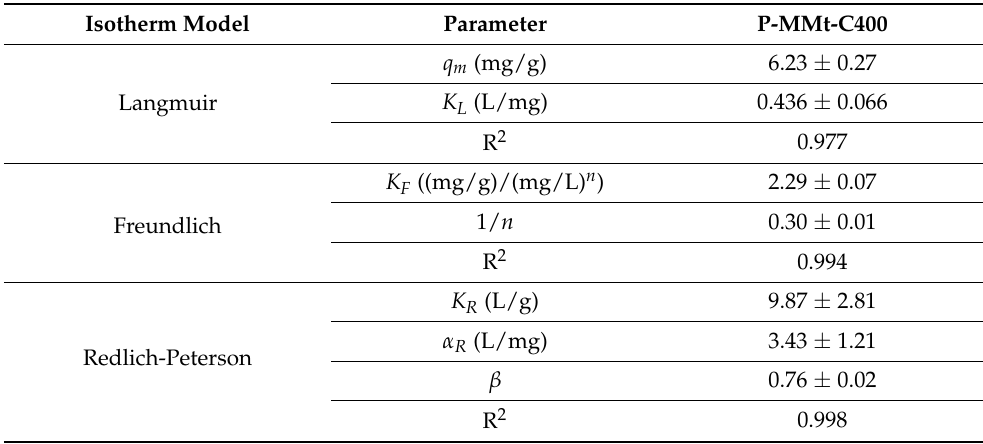
Table 5. Parameters of the Langmuir, Freundlich, and Redlich–Peterson models fitted to the adsorp- tion of MO onto P-MMt-C400.